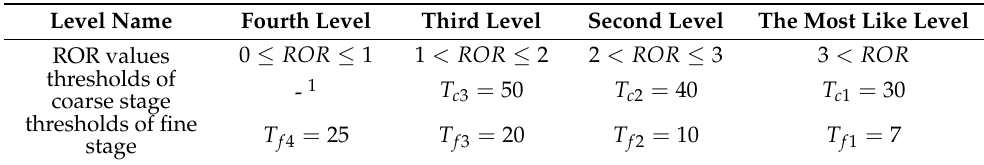
Table 1. Level of ROR and its corresponding threshold.